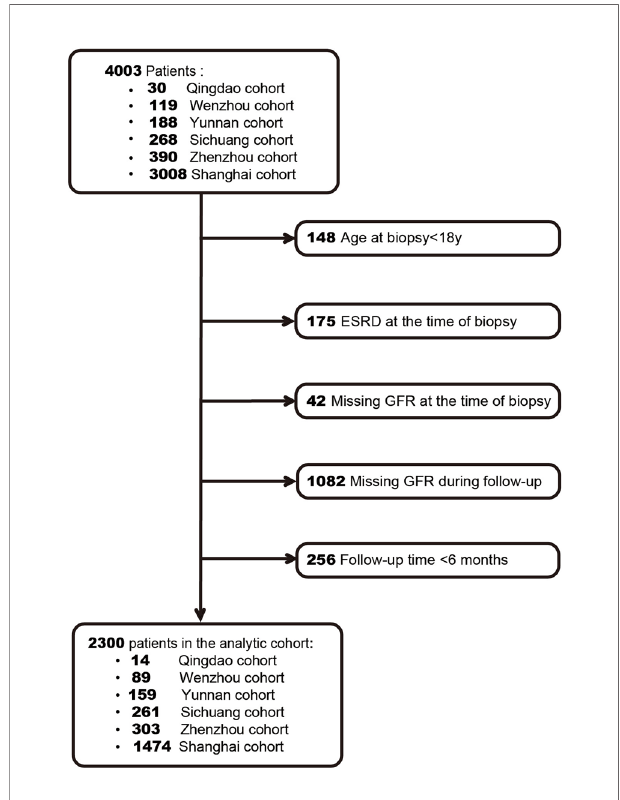
FIGURE 1 | Flowchart of patient